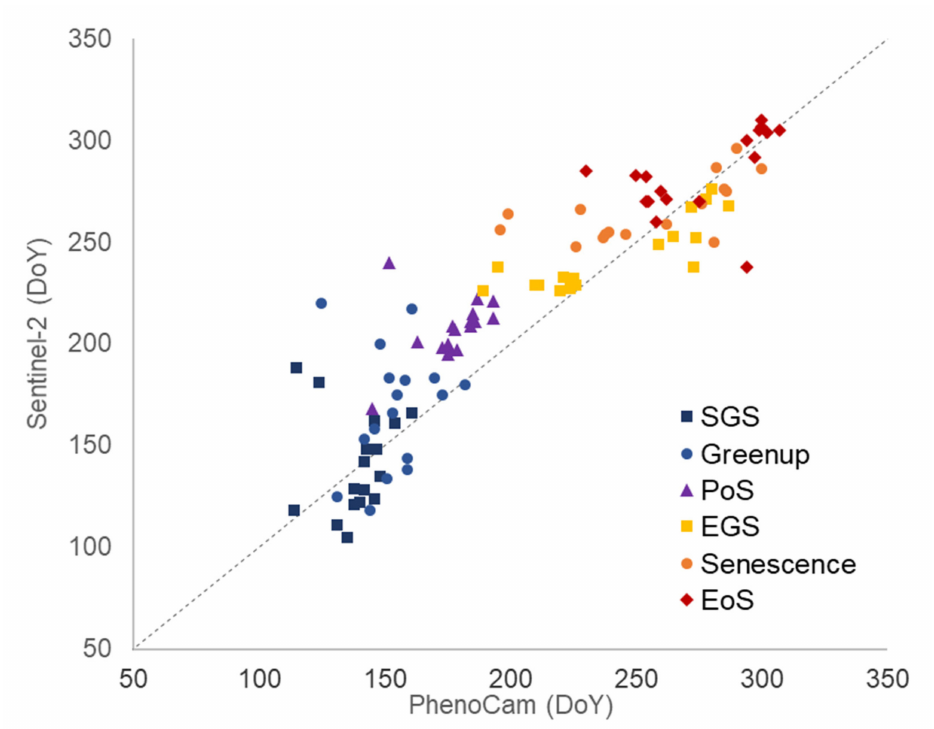
Figure 5. Phenological metrics dates (expressed as DoY) derived from the GCC 90 time series on the x -axis plotted against the estimates from S2 LAI on the y -axis. The dashed black line shows the 1:1